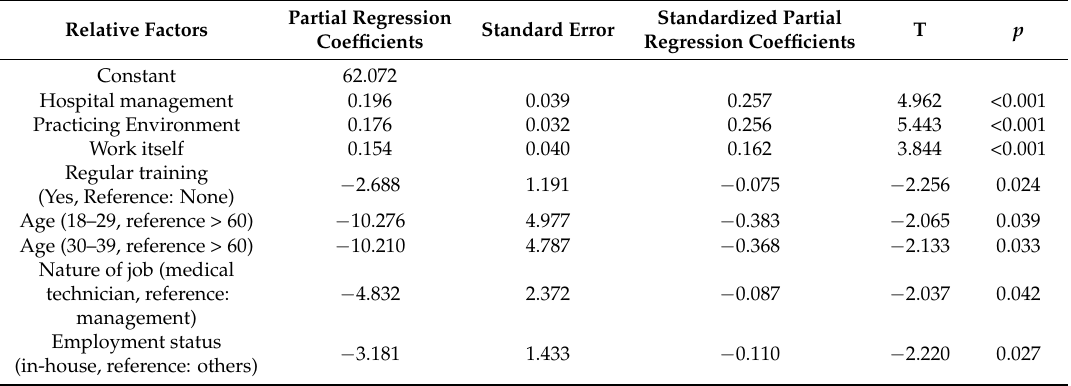
Table 6. Results of multi-factor linear regression analysis for the medical staff’s job satisfaction.